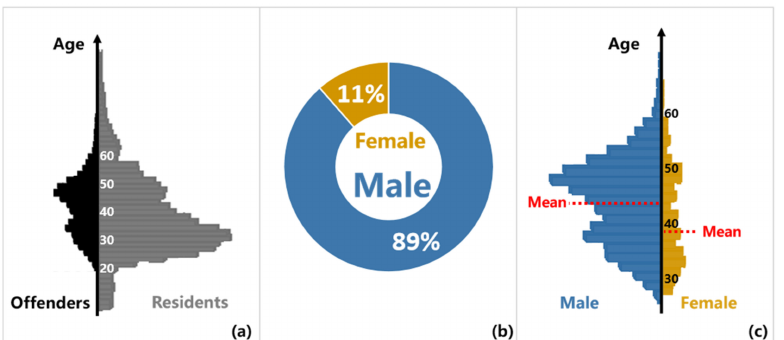
Figure 6. The age structure of offenders and the total population ( a ), the gender structure of the offenders ( b ), and the age structure of female and male offenders ( c ).